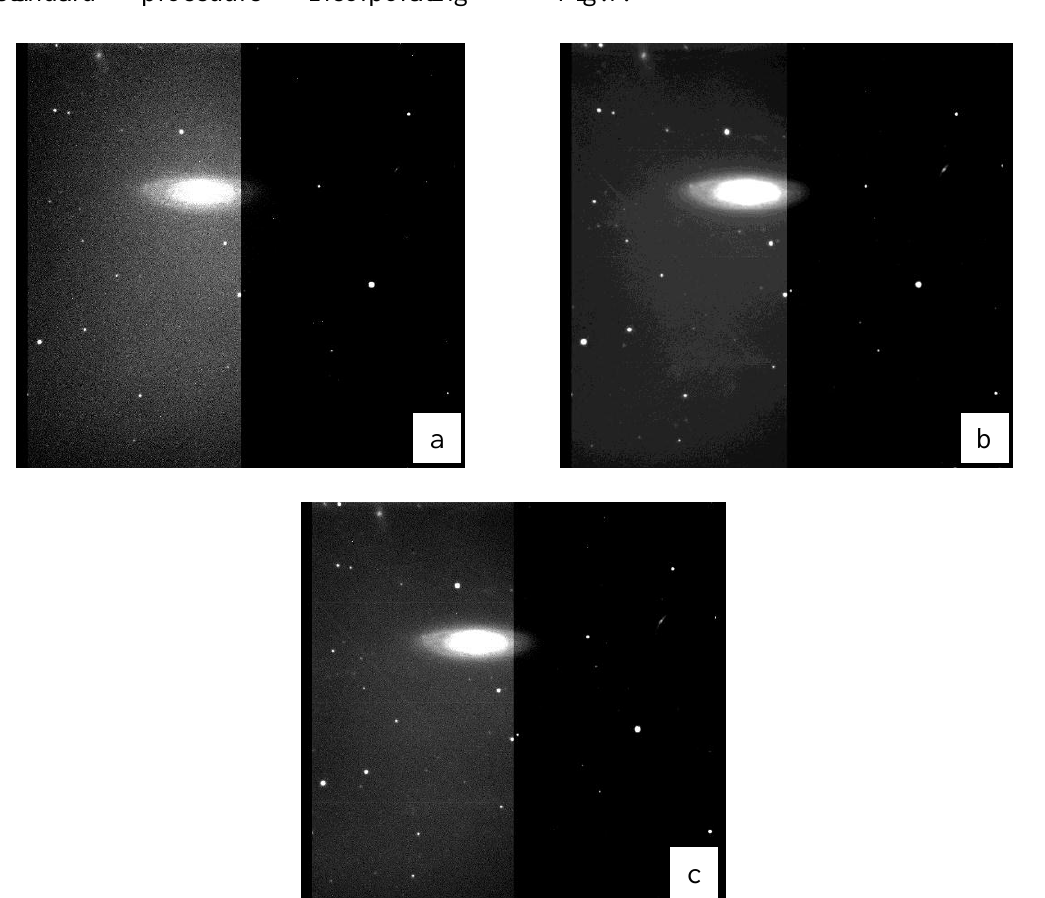
a b Fig.1: CCD image of NGC 4448 before reduction (a) B filter (b) V filter (c) R filter.